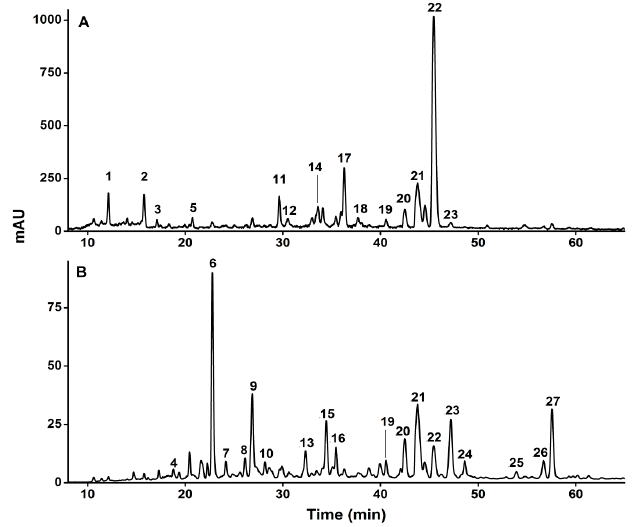
Figure 1. The HPLC profiles of phenolic compounds in fraction I from D. indica recorded at 260 nm ( A ) and 360 nm ( B ). The peak numbers correspond to those used in Table 1. Table 1. Qualitative and quantitative analysis of 27 phenolic compounds in fraction I from D. indica.